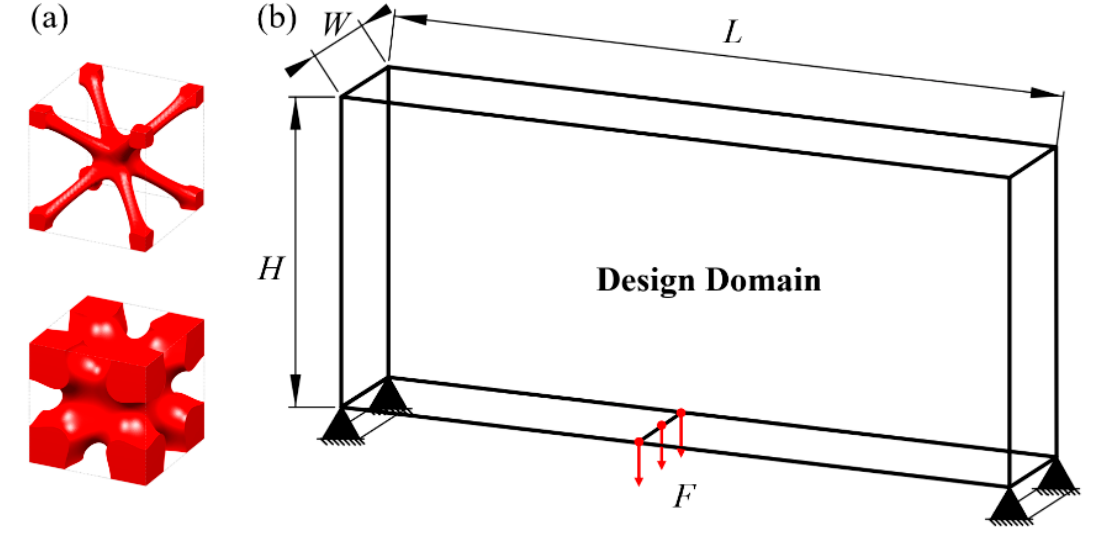
Figure 12. Pre-defined unit cells and design domain of FGCS. ( a ) I-WP TPMS with different volume fractions. ( b ) Loading and boundary conditions for 3D Michell beam.